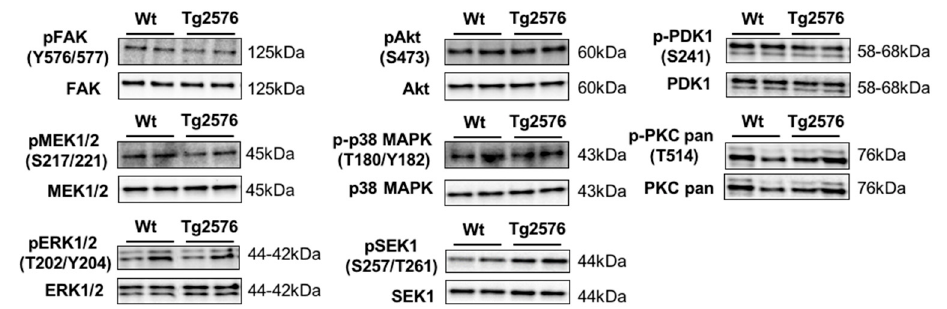
Figure 4. Activation state of specific survival pathways in the OB of aged Tg2576 mice. Levels and residue-specific phosphorylation of focal adhesion kinase (FAK), ERK Activator Kinase 1 (MEK)/extracellular signal-regulated kinase (ERK), protein kinase B (Akt), phosphoinositide- dependent protein kinase 1 (PDK1), protein kinase C (PKC), p38 mitogen-activated protein kinase (p38 MAPK), and mitogen-activated protein kinase kinase 4 (SEK1/MKK4), in the OB of aged Tg2576 mice. Equal loading of the gels was assessed by stain free digitalization. Equal loading control and quantitation values have been included in Table S5.